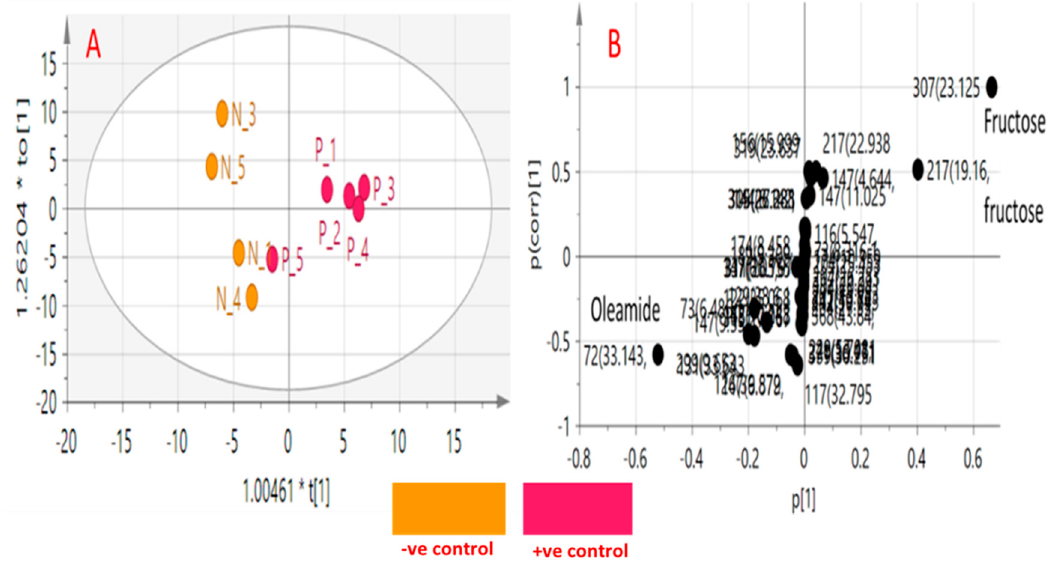
Figure 8. Orthogonal partial least-squares-discriminant analysis (OPLS-DA) score plots obtained from modeling colitis (p) versus healthy control groups (N) against each other. ( A ) Score plot of PC1 and PC2. ( B ) S-plot showing the covariance p [1] against the correlation p(cor) [1] of the variables of the discriminating component. Each metabolite in panel B is denoted by its quantification mass and (peak retention time in min). Table 2. Metabolites fold change calculated by dividing the mean of each metabolite peak intensity from each of the two groups. Statistical significance was revealed using the non-parametric Mann-Whitney test. Results were considered only significant if p ≤ 0.05 using Kruskal-Wallis test